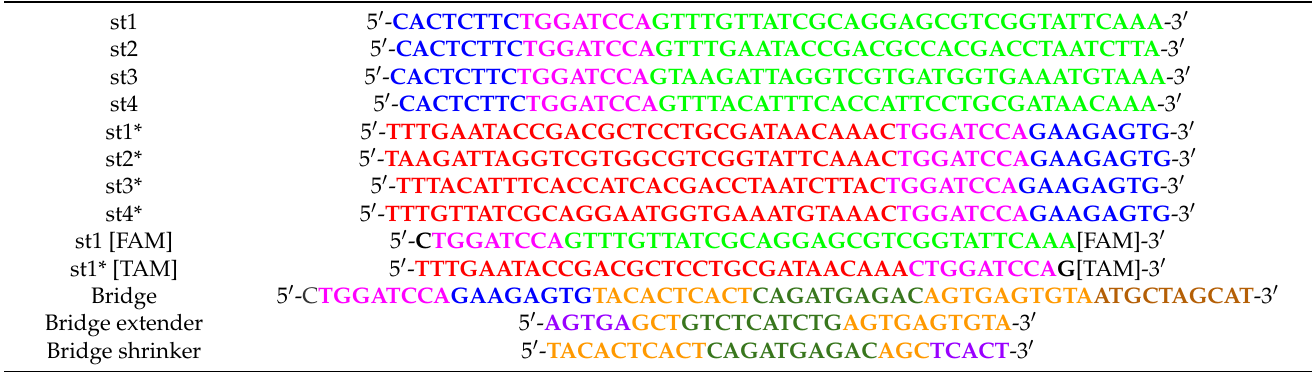
Table 1. Sequences of DNA strands used in this